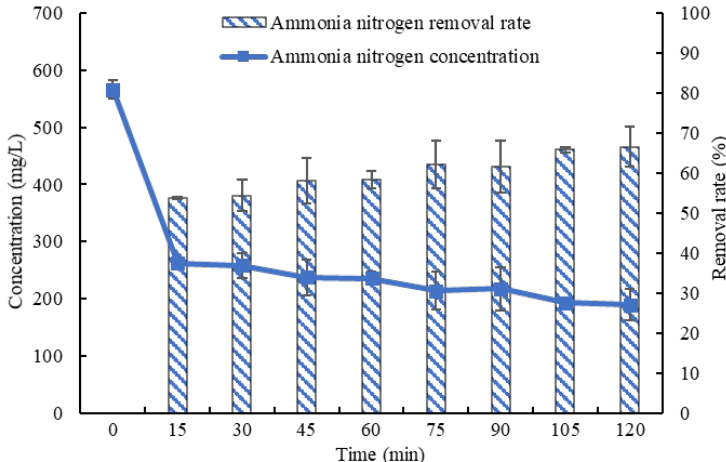
Figure 2. Variations in the concentration and removal rate of ammonia nitrogen with time in biogas slurry.